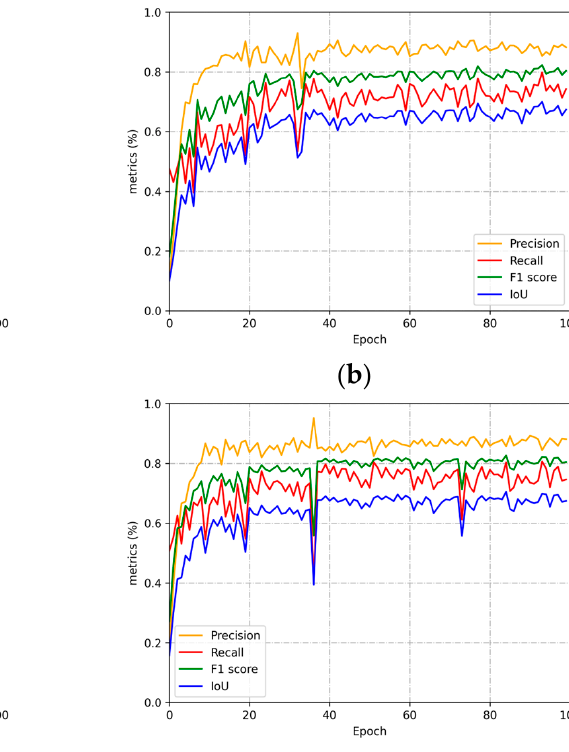
Figure 4. The metrics Precision, Recall, IoU, and F1 score as obtained from U-Net for different back- bones: ( a ) vgg16, ( b ) resnet152, ( c ) densenet201, ( d ) inceptionv3.